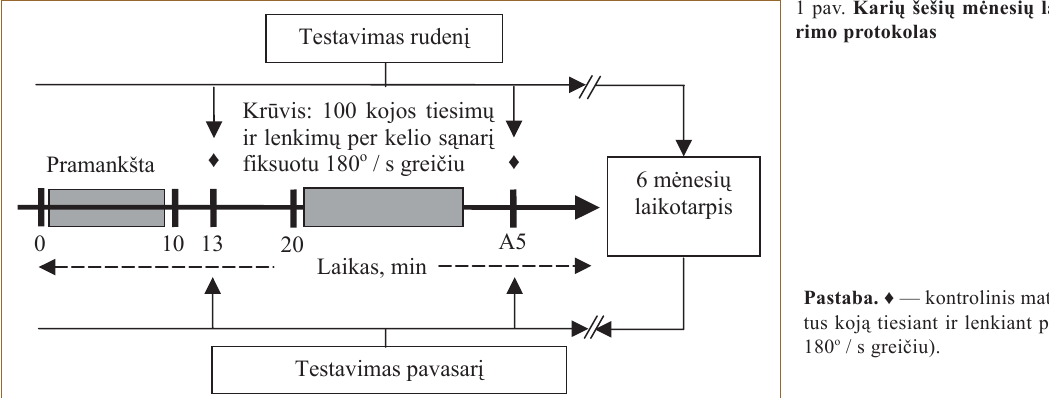
3. Pra ė jus 5 minut ė ms po kr ū vio, buvo registruo- jami atsigavimo rodikliai — 3 kartus tiesiant ir lenkiant koj ą per kelio s ą nar į fi ksuotu 180 o / s grei č